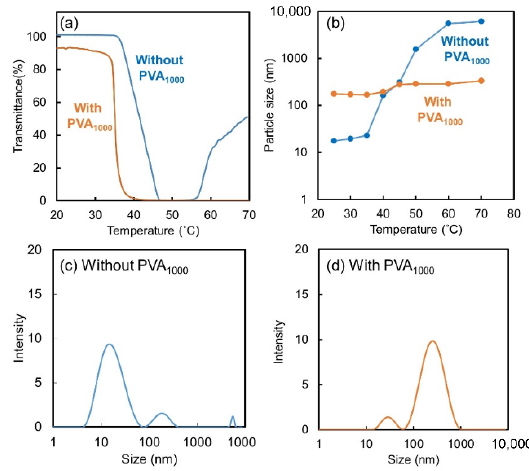
Figure 1. Transmittance ( a ) and average particle size ( b ) of PG 0 and PG 1000 dispersions at various temperatures. Particle size distributions of obtained PG 0 particles (prepared without PVA 1000 , ( c )) and PG 1000 particles (prepared with PVA 1000 , ( d )) at 30 °C. PG 0 and PG 1000 particles were prepared via precipitation and dispersion polymerizations with PVA 1000 (3 mg/mL) at 70 °C for 3 h.